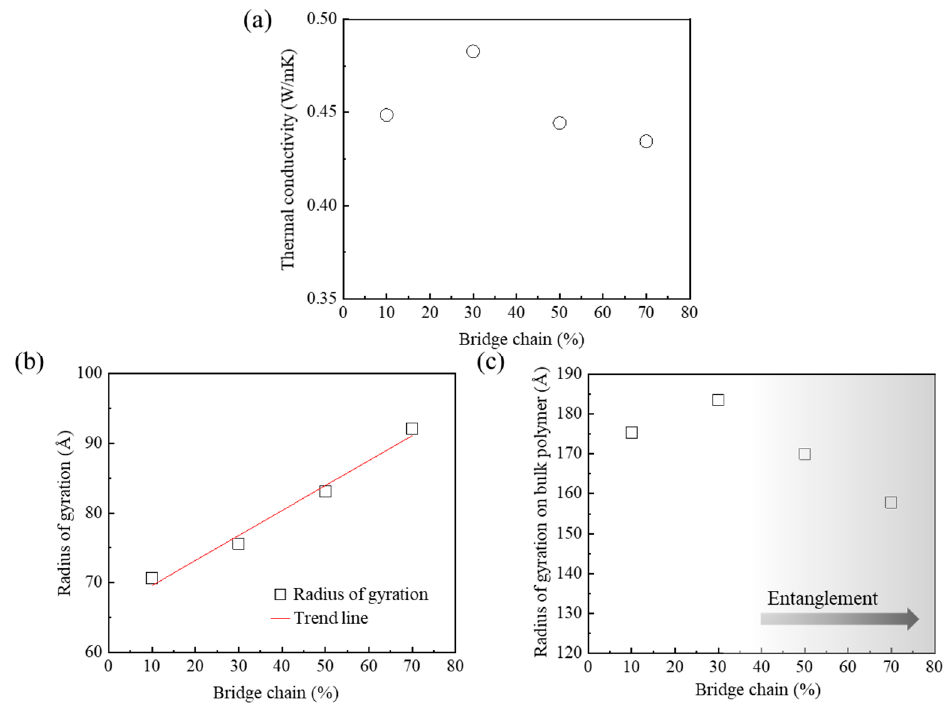
Figure 5. Thermal transport according to the content of bridge conformation: ( a ) thermal conduc- tivities, ( b ) radius of gyration, and ( c ) radius of gyration on bulk polymer. ties, ( b ) radius of gyration, and ( c ) radius of gyration on bulk